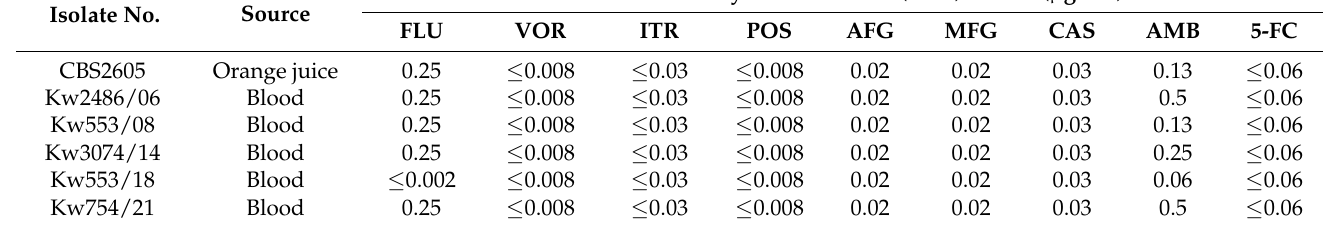
Table 1. In vitro antifungal susceptibility testing results of reference strain and clinical L. elongisporus isolates from